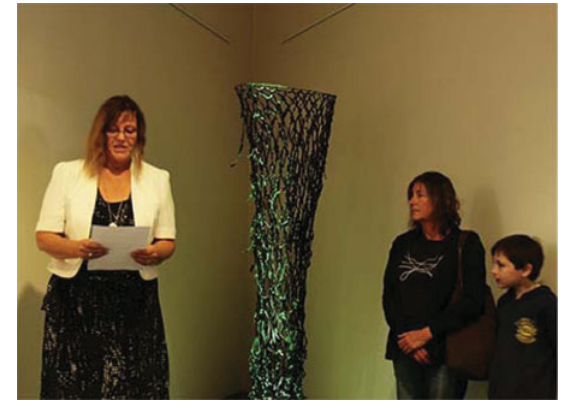
FIGURE 2 (Colour online) Brigitte welcoming people at the Gallery